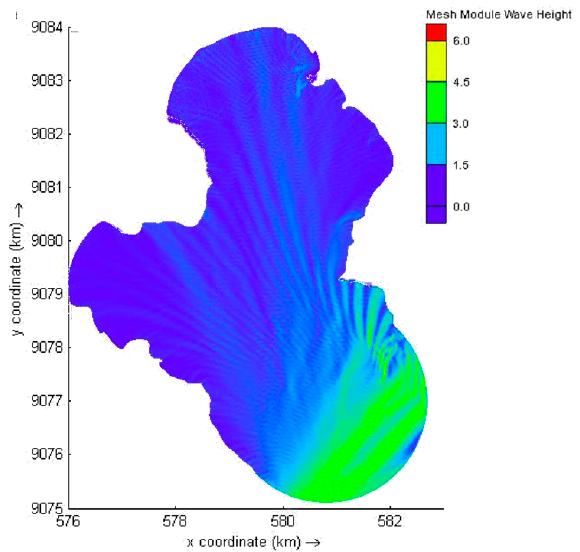
Figure 10. Results Wave Height Modeling in January.